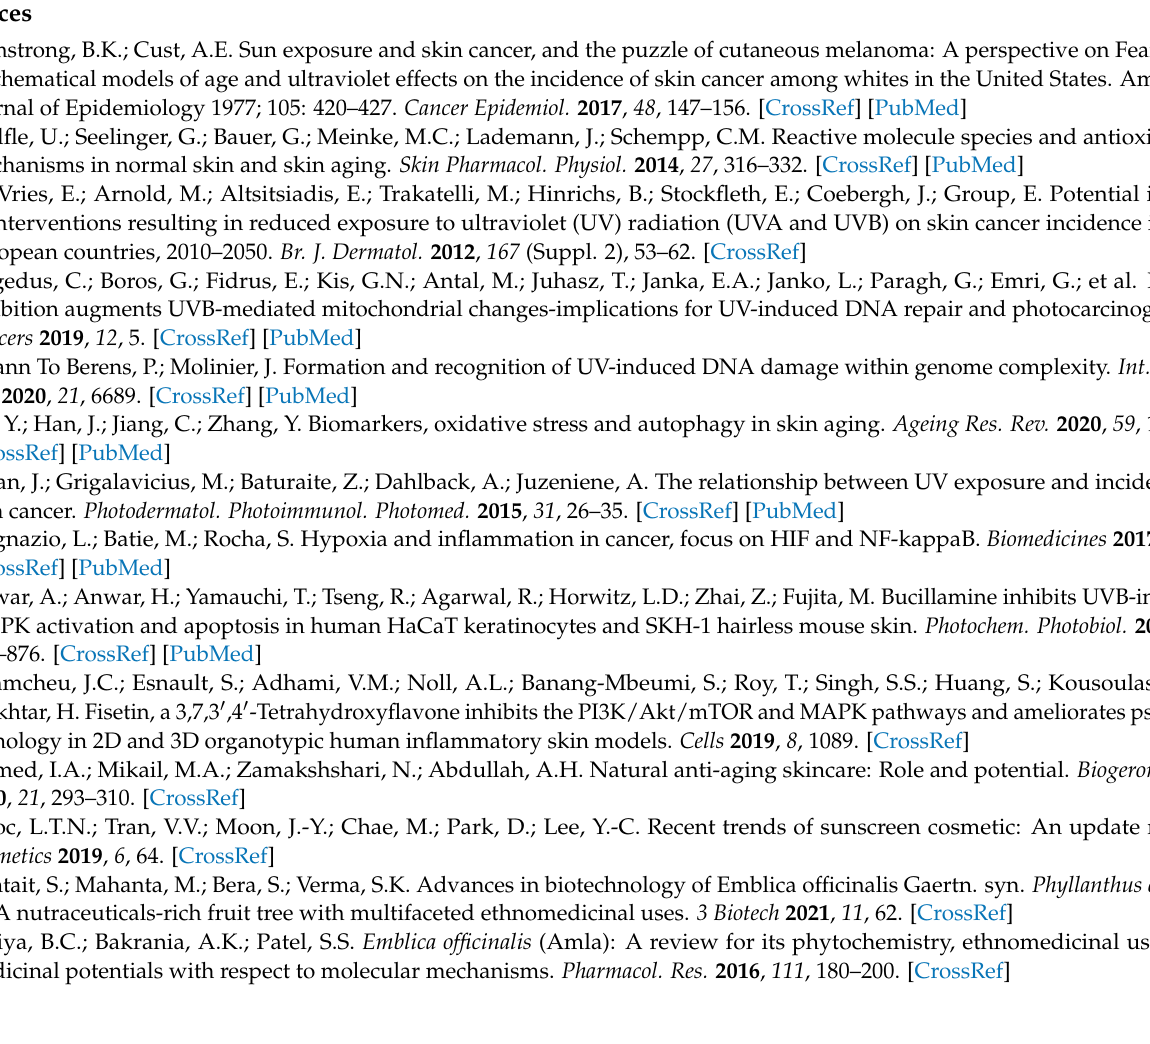
corresponding standards. Figure S2: The effects of UVB and PE on the HaCaT cell viability. (a) The relative cell viability of HaCaT cells after irradiation with various doses of UVB. (b) The effects of PE pretreatment followed by UVB irradiation. Figure S3: Original images of western blot band intensities in Figure 4. Figure S4: Original images of western blot band intensities in Figure 5. Figure S5: Original images of western blot band intensities in Figure